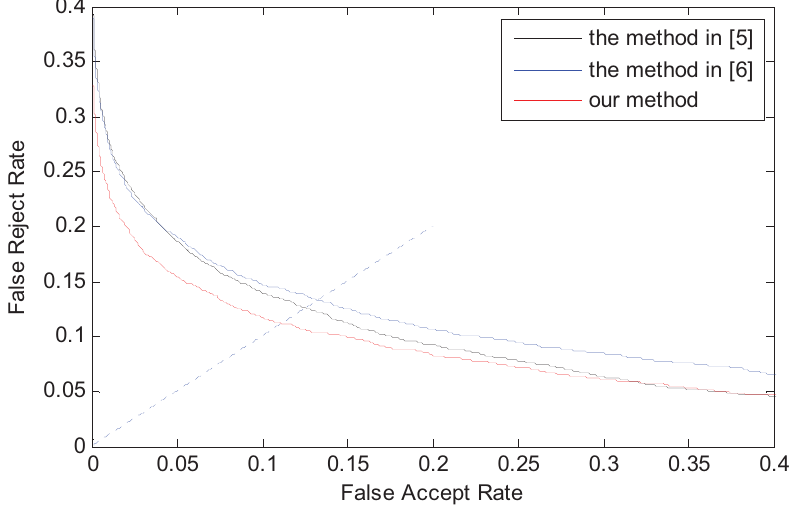
Figure 11. ROC curves by different ROI localization methods.